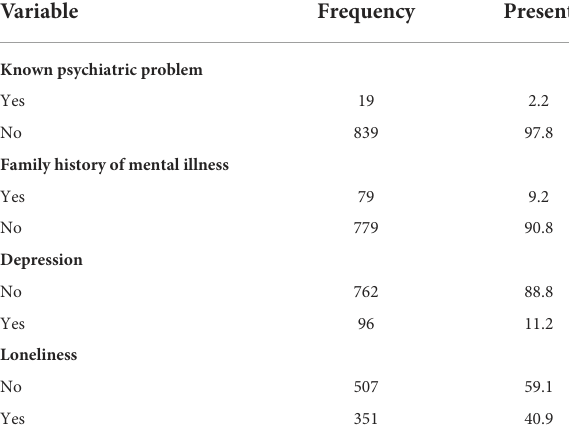
TABLE 2 Reproductive, obstetrics, and medical-related characteristics of study participants in Gondar town, Northwest Ethiopia, 2021 ( n =